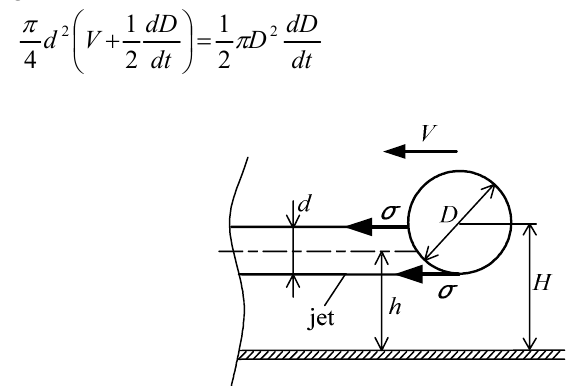
Fig. 9 Schematic of the swelling behavior at the jet